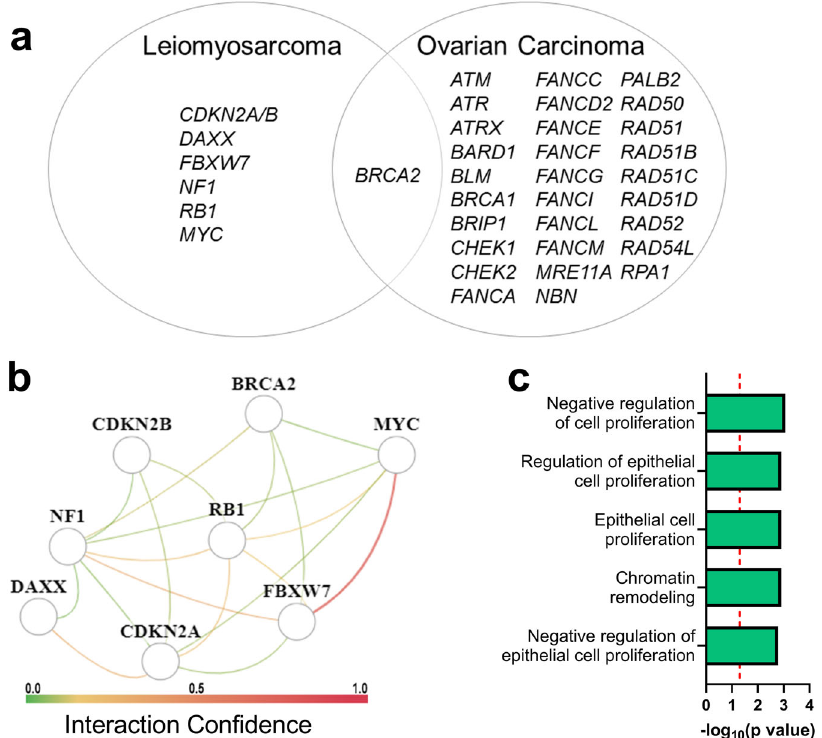
inhibition. Gene alterations correlated to gLOH in LMS were notably different from those identi fi ed in ovarian carcinoma 25 . b , c Tissue-speci fi c network analysis using humanbase identi fi ed common signaling connections between twelve genomic alterations associate with increased gLOH. Biological process enrichment identi fi ed patterns of cell proliferation and chromatin remodeling in this gene